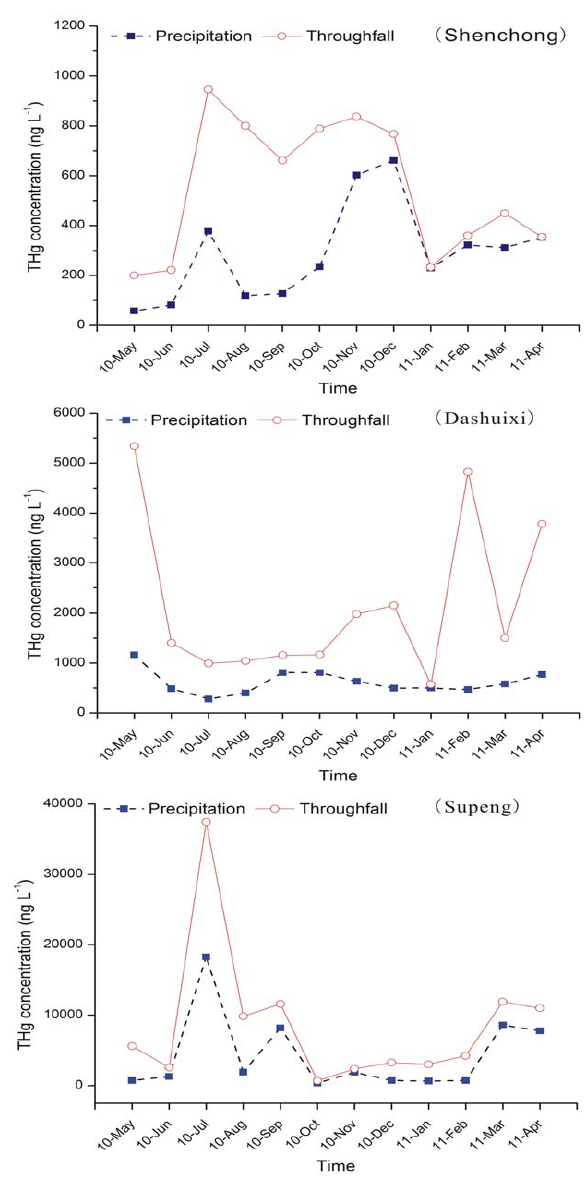
Fig. 3. Monthly mean THg concentrations in precipitation and throughfall during the period May 2010–May 2011 (Shenchong up- per panel, Dashuixi mid panel and Supeng site lower